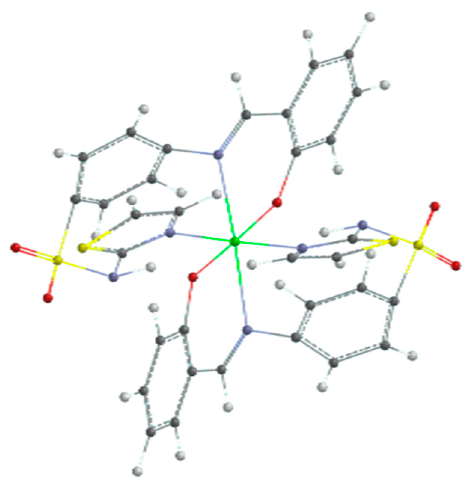
Figure 12. Optimized geometry of copper(II) complex (color codes are white: H; red: O; blue: N; black: C; yellow: S; and green: Cu).